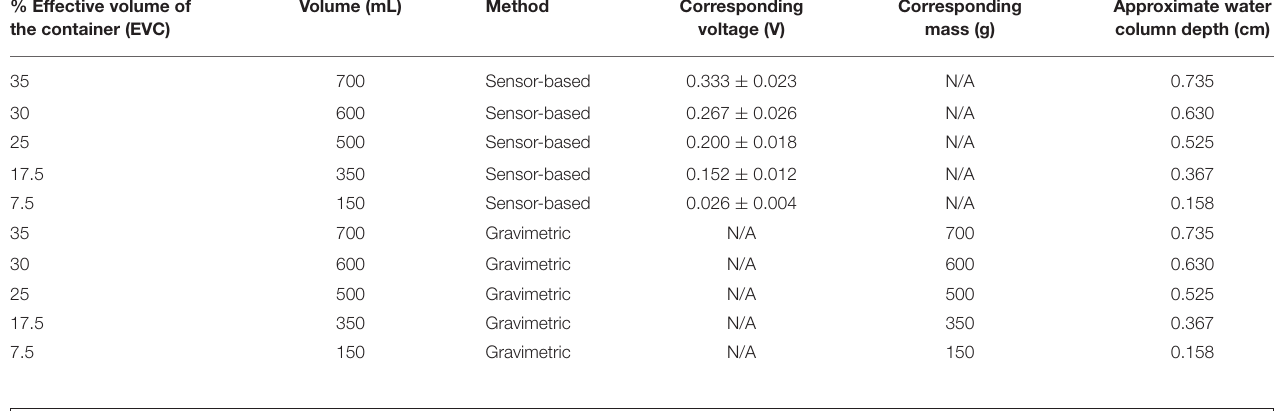
TABLE 2 | Description of irrigation treatments in two irrigation methods and their corresponding voltage or mass. % Effective volume of the container